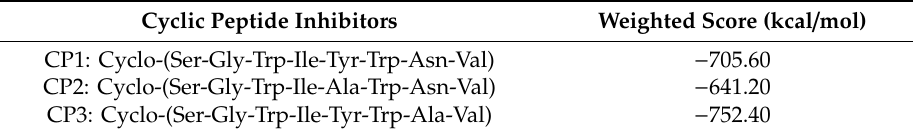
Table 2. Of cyclic peptide binding interactions for ClusPro docking